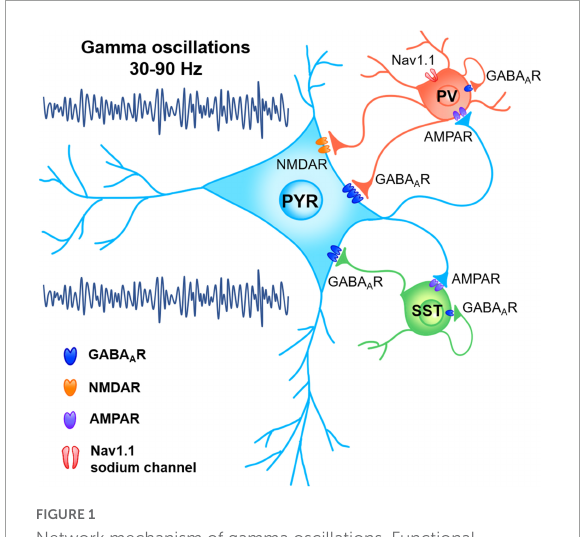
FIGURE1 Network mechanism of gamma oscillations. Functional connectivity between pyramidal neurons (PYR) and inhibitory interneurons, including parvalbumin expressing (PV) and somatostatin expressing (SST) neurons, dynamically organized the synchronous oscillations in gamma band through pyramidal-interneuron network gamma (PING) or interneuron network gamma (ING)